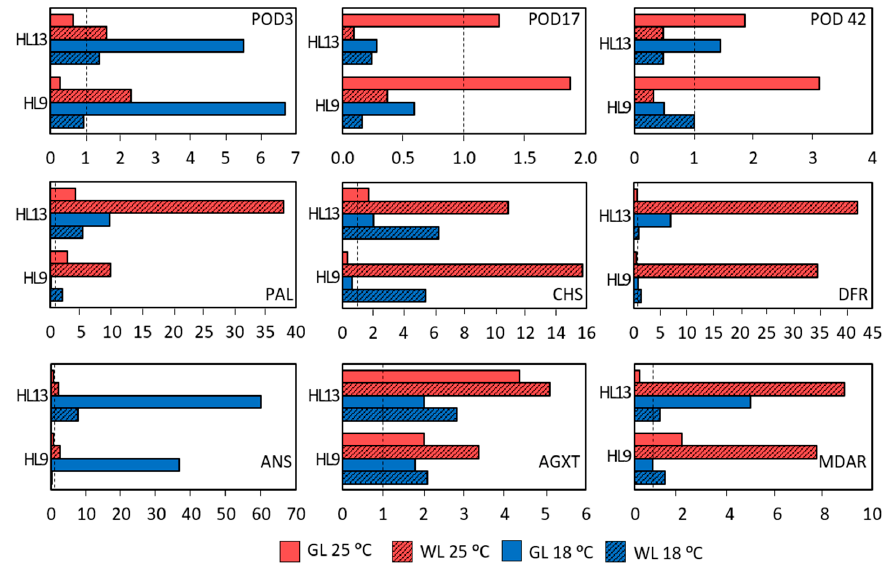
Figure 15. Relative expression of selected genes in GL (solid boxes) and WL (striped boxes) of P. zonale plants in comparison with the beginning (5 days) and after four (HL9) and eight days (HL13) of high light exposure (HL, 800 µmol m –2 s –1 , red bars) at the optimal temperature of 25 °C ( HL , red) and lower temperature of 18 °C ( Cold + HL , blue). The values of the relative gene expression changes were calculated by applying the actin gene reference. POD3 , POD17 , POD42 , class III peroxidase isoforms ; MDAR , monodehydroascorbate reductase ; PAL , phenylalanine ammonia lyase ; CHS , chalcone synthase ; DFR , dihydroflavonol-4-reductase ; ANS , anthocyanidin synthase ; AGXT , alanine:glyoxylate aminotransferase.